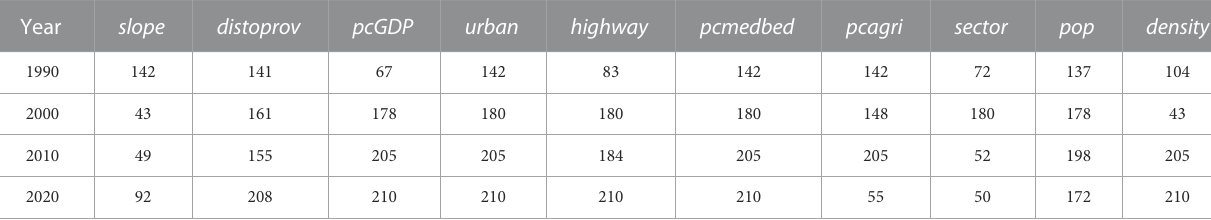
TABLE 4 Bandwidth of different in fl uencing factors of